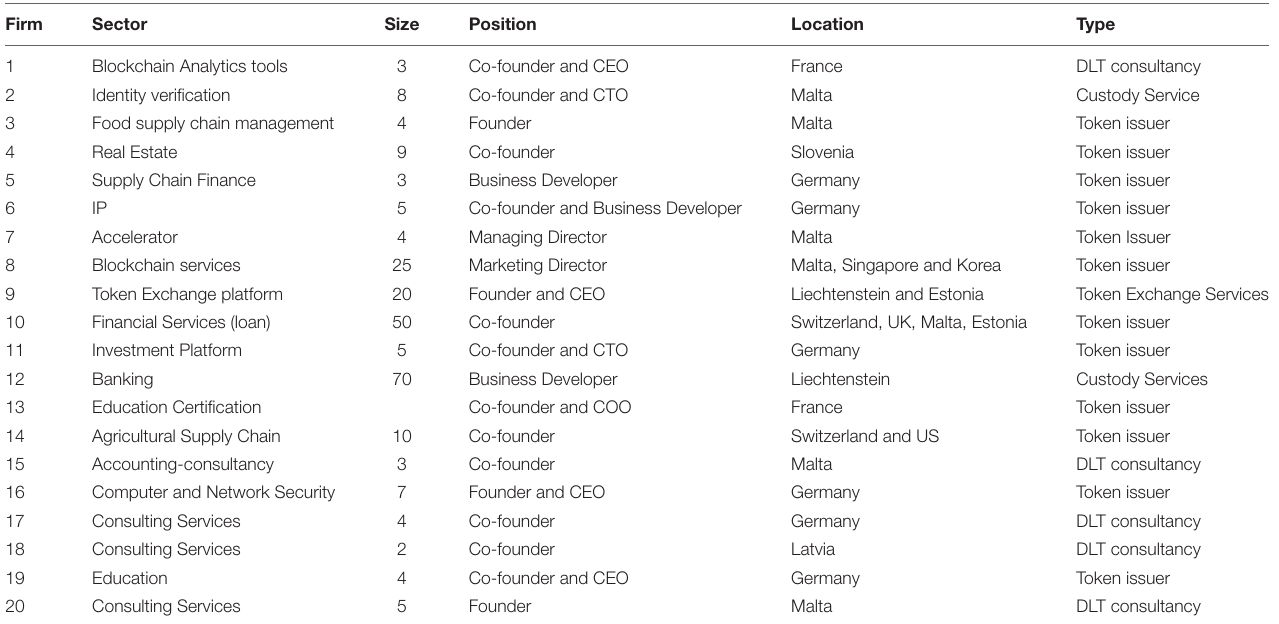
FIGURE 3 | Interview flow. TABLE 1 | Sample